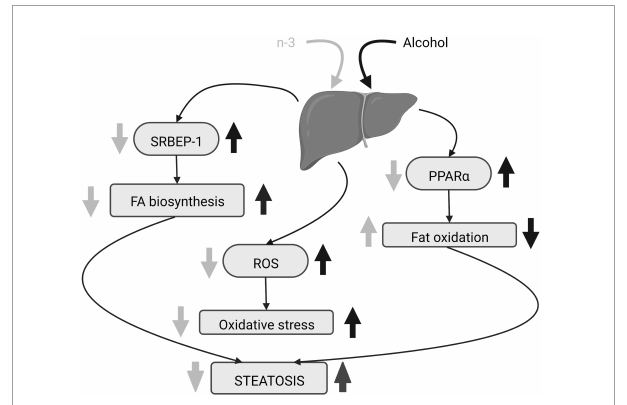
FIGURE3 Alcohol-induced hepatic steatosis and n-3 effects. The increase in SRBEP-1 and ROS by alcohol elevates liver FA biosynthesis and oxidative stress, respectively, and alcoholic PPAR α rise reduces liver fat oxidation. The consequence is steatosis. N-3 enriched diet lowers SRBEP-1 and ROS, decreasing liver FA biosynthesis and oxidative stress. It also promotes liver fat oxidation by downregulating activation of PPAR α . Altogether, n-3 ameliorates steatosis. Created with